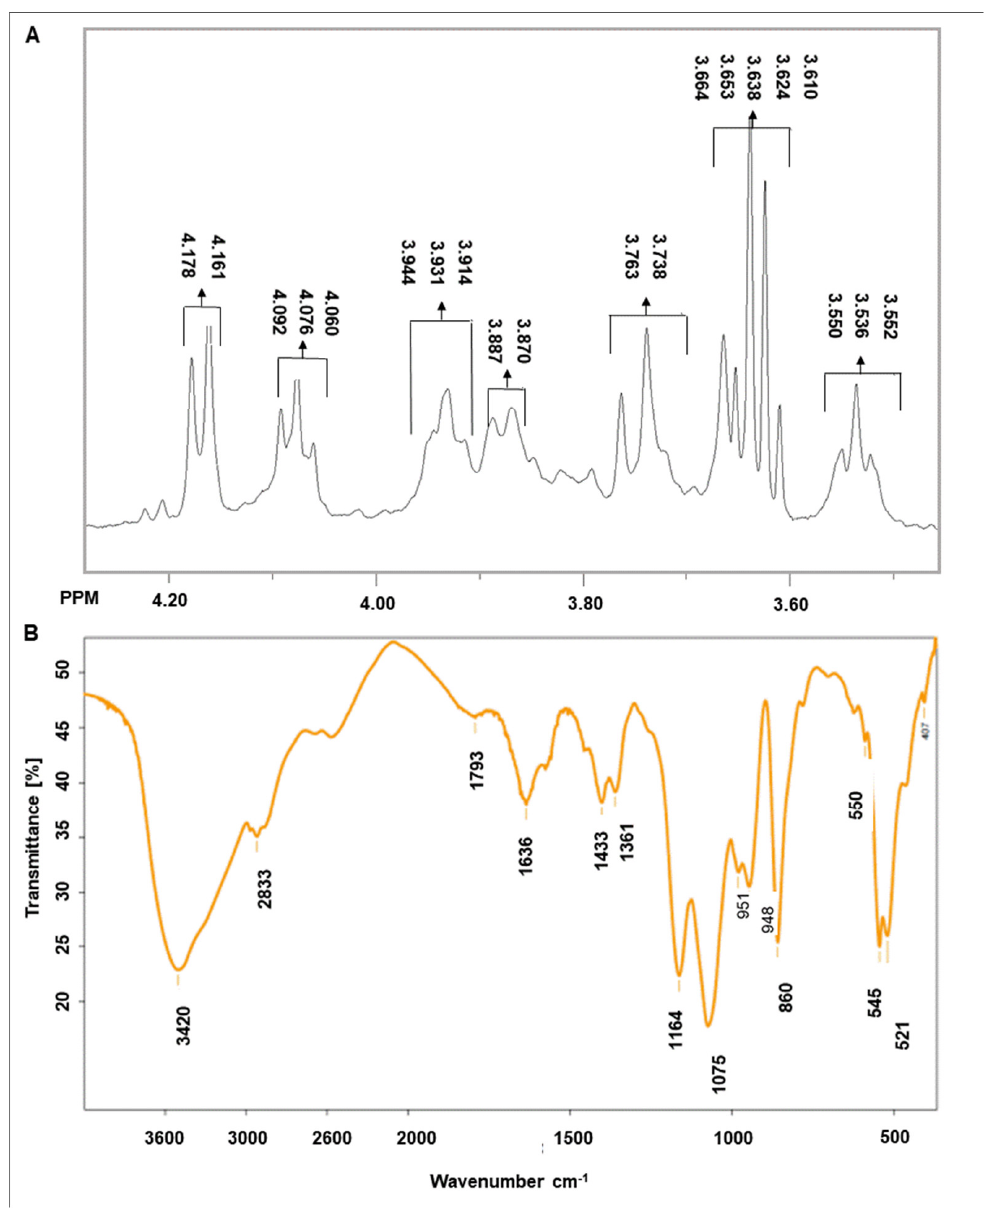
Figure 1. Spectra of levan from B. subtilis natto KB1—( A ) 1 H NMR, ( B ) IR. Table 1. Influence of Bacillus -fermented supernatant on selected pathogenic strains—inhibition zone, MIC value, biofilm formation and adhesion to the polystyrene